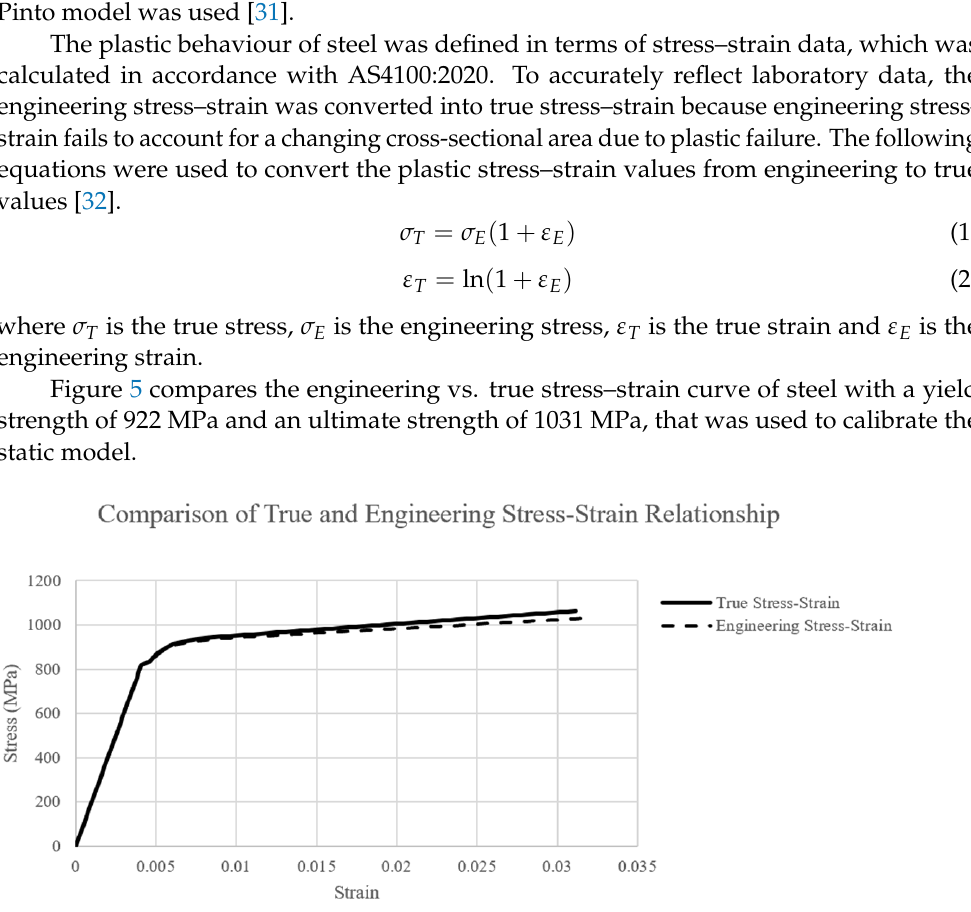
Table 4. Elastic steel properties of the 63T Sumo cable bolt.